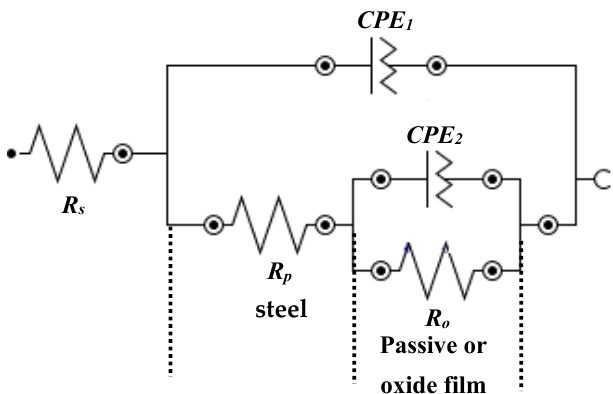
Figure 7. EEC of steel rebar samples exposed in 3.5 wt% NaCl contaminated concrete pore solution with and without (bare) inhibitor.